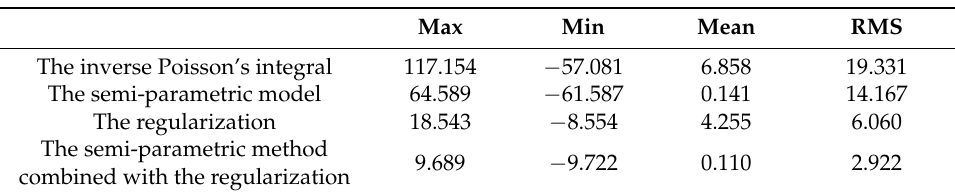
Table 3. Statistics of the differences between the downward continued values and the original values in the Louisiana Gravity Project (mgal).